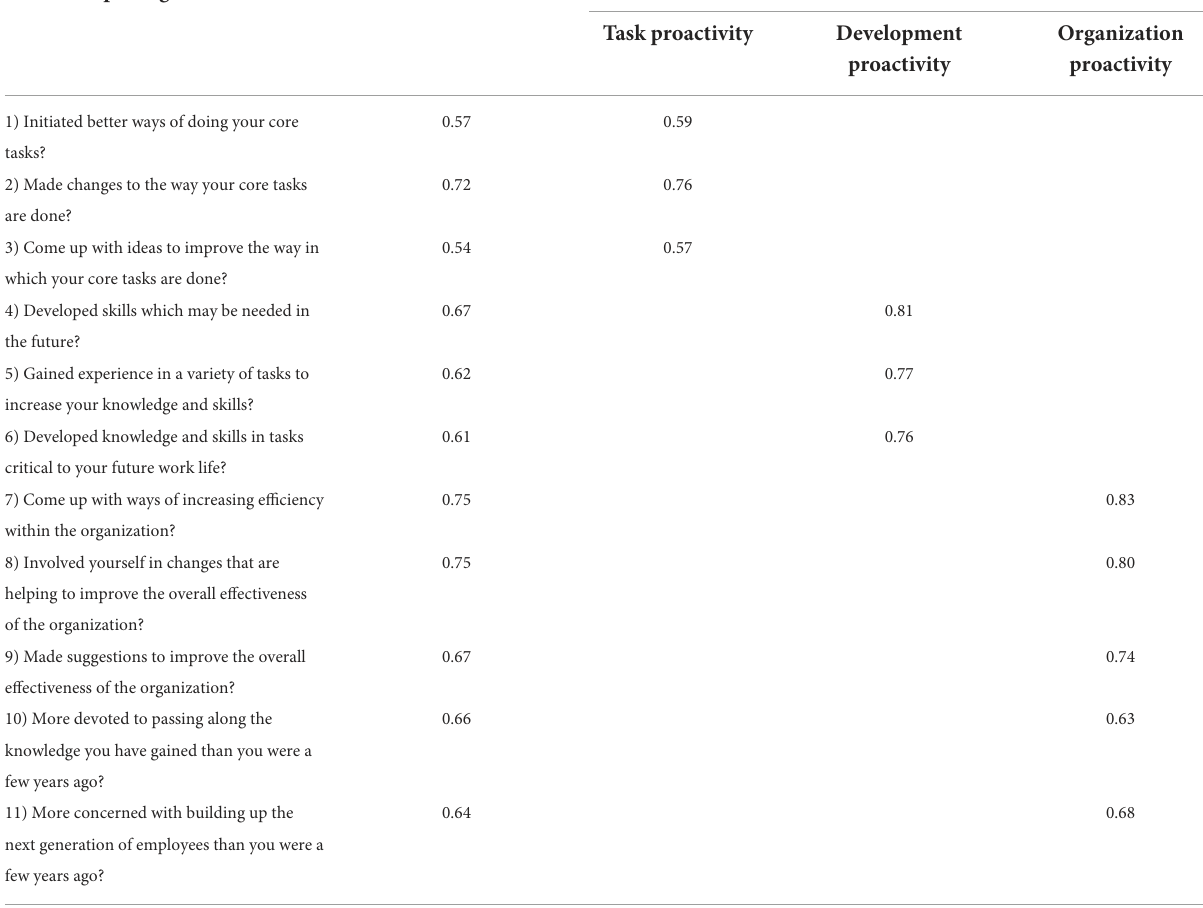
TABLE 3 Factor loadings of one- and three-factor models of proactivity. Items comprising scale One-factor model